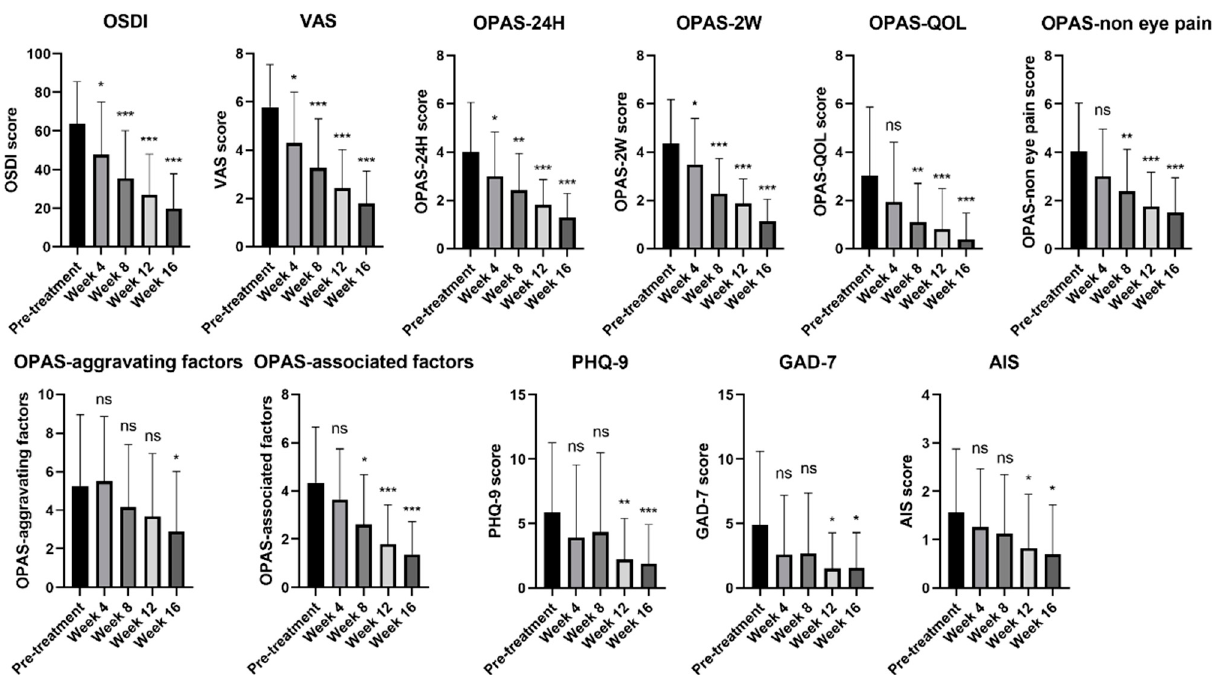
Figure 1. Changes of DED symptoms and ocular pain before and after treatment of IPL